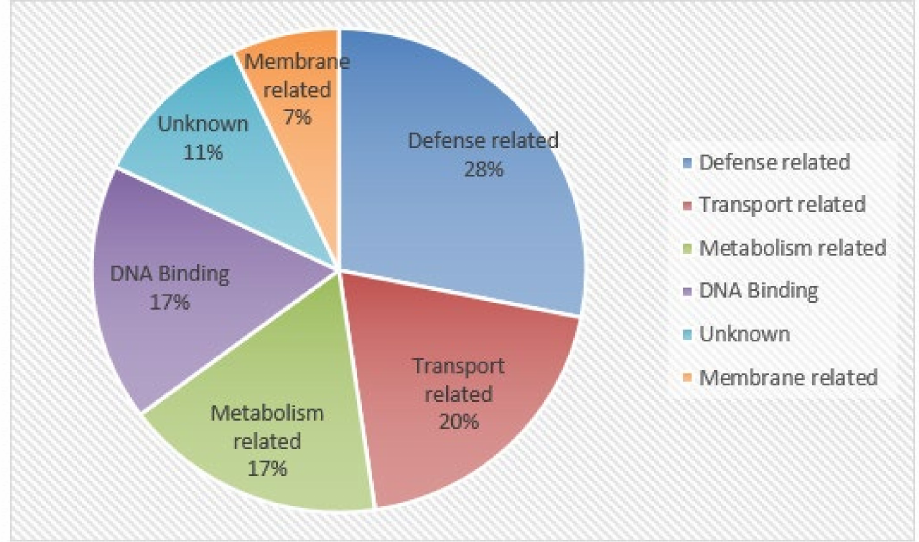
Figure 3. Function classification of potential soybean proteins interacting with 6K1 based on their putative